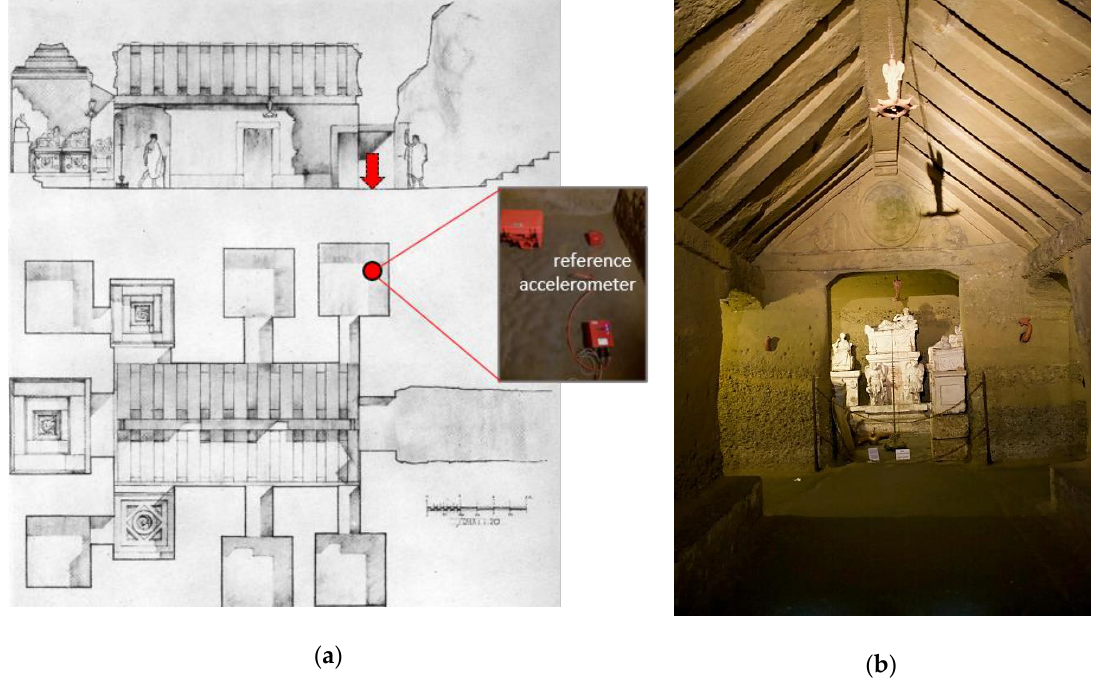
Figure 6. Volumni Hypogeum: cross section and plan view ( a ), adapted from [27]). Photo from the inside ( b ). The red symbol and the arrow in Figure 6a indicate the location of the reference accelerometer.